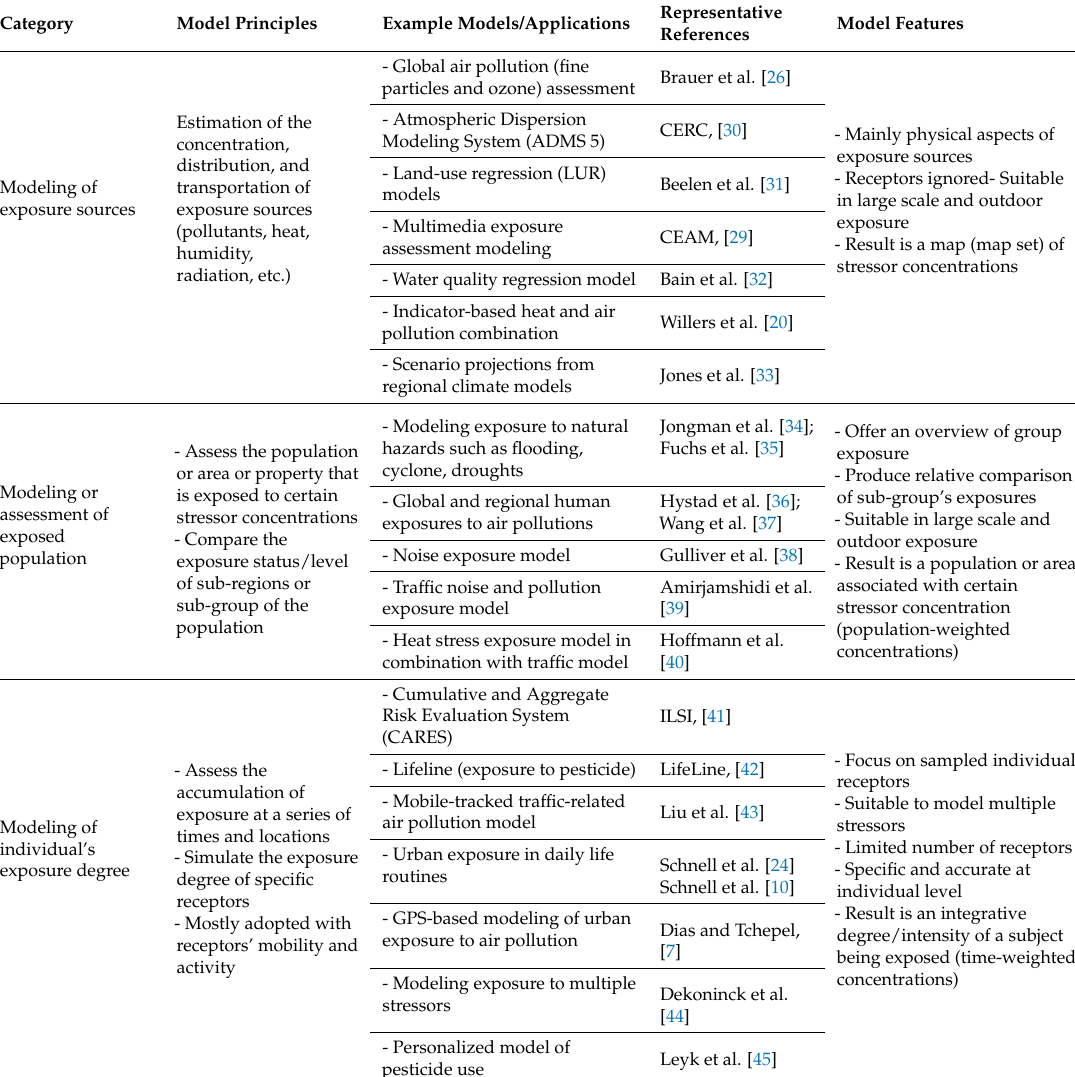
Table 1. Selected sample models in studying human exposure to environmental